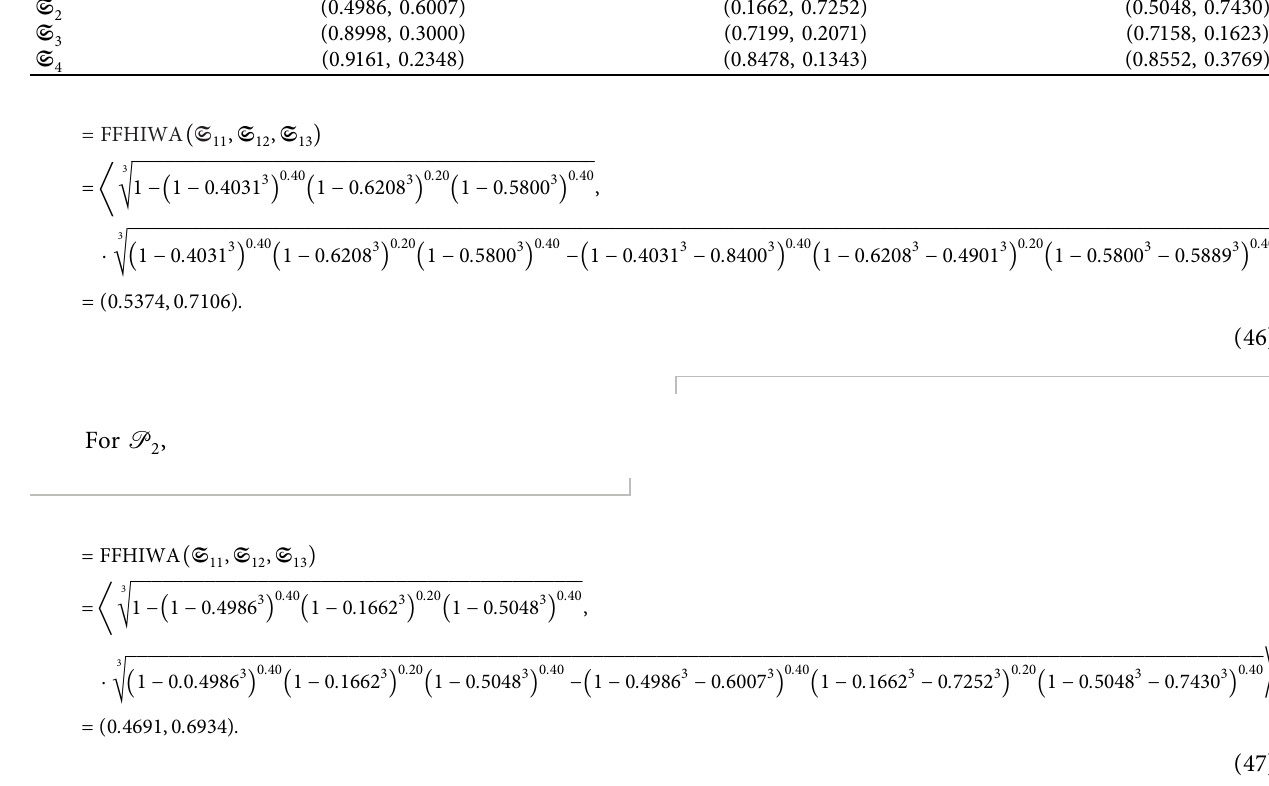
Table 2: Air quality data by expert E